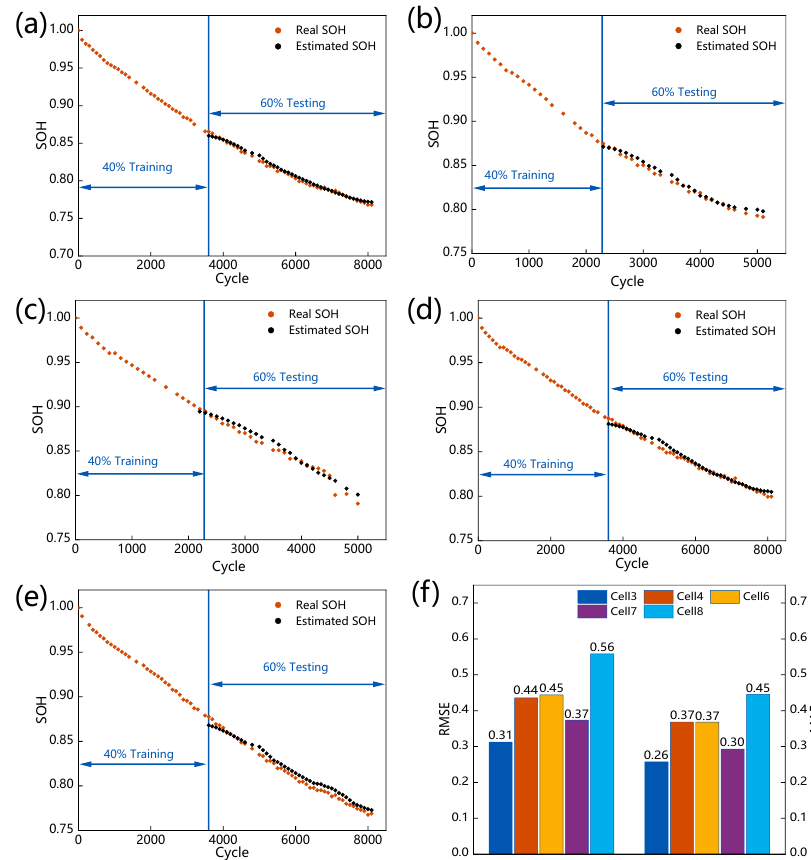
Figure 8. Results on Oxford battery based on collaborative features: ( a ) Cell 3; ( b ) Cell 4; ( c ) Cell 6; ( d ) Cell 7; ( e ) Cell 8; ( f ) MAE and RMSE analyses.